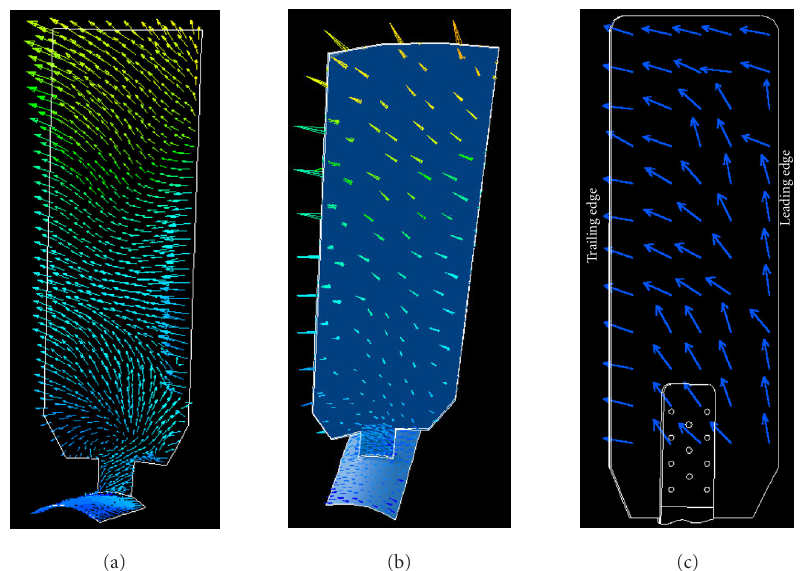
Figure 24: Comparison of CFD simulation and flow visualization technique (tuft method): (a) CFD with radiator; (b) CFD without radiator; and (c) flow visualization without